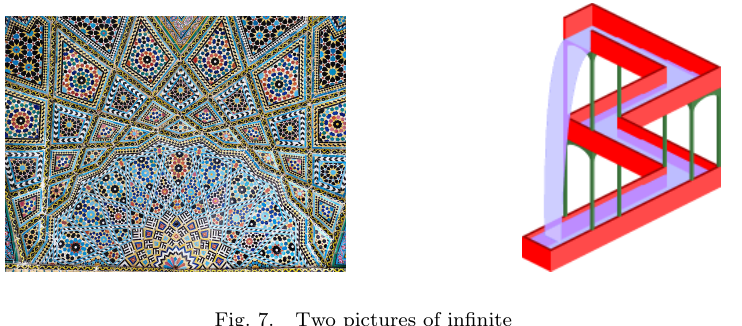
Fig. 7. Two pictures of